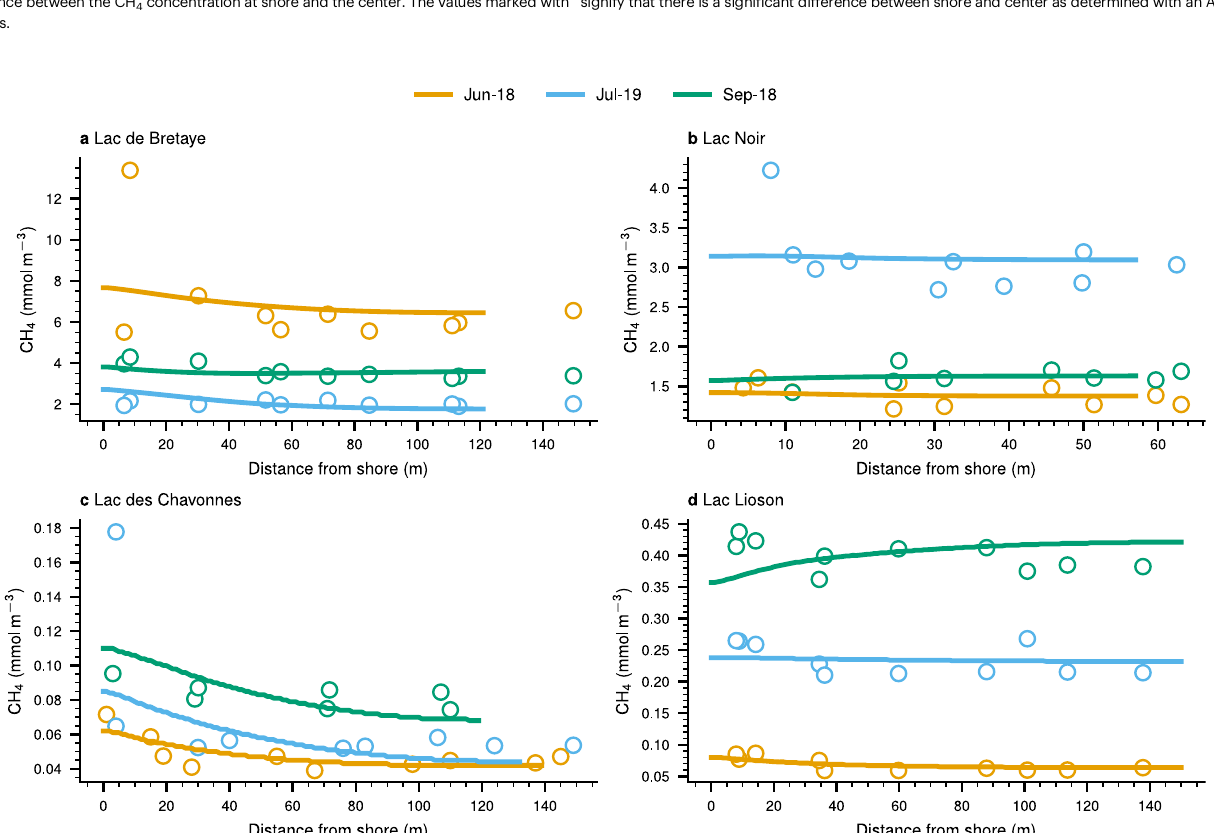
concentrations in the SML are radially symmetric, the concentrations are shown from shore to center. The bathymetry pro fi le along the transects is shown